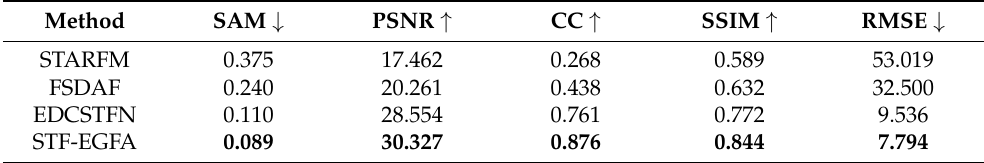
Table 3. Objective evaluation of the Tianjin test set.